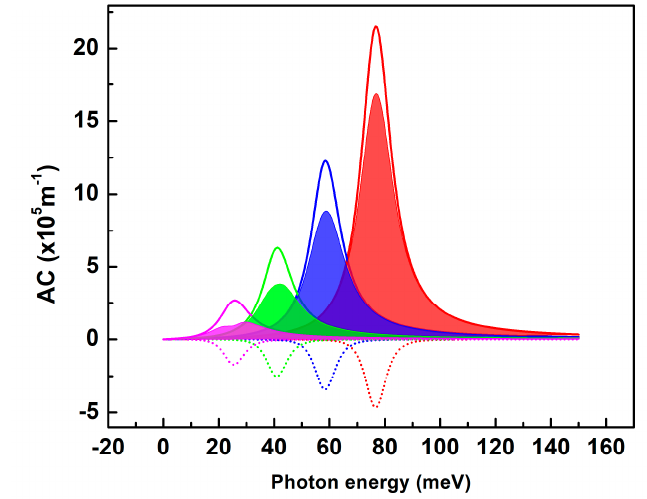
Figure 5. Calculated linear (solid lines), 3rd order nonlinear (dotted lines) and total absorption coefficient (AC) (filled area curves) as a function of photon energy for a selection of QD sizes: D = 20 nm (red), D = 26 nm (blue), D = 32 nm (green), D = 40 nm (pink).